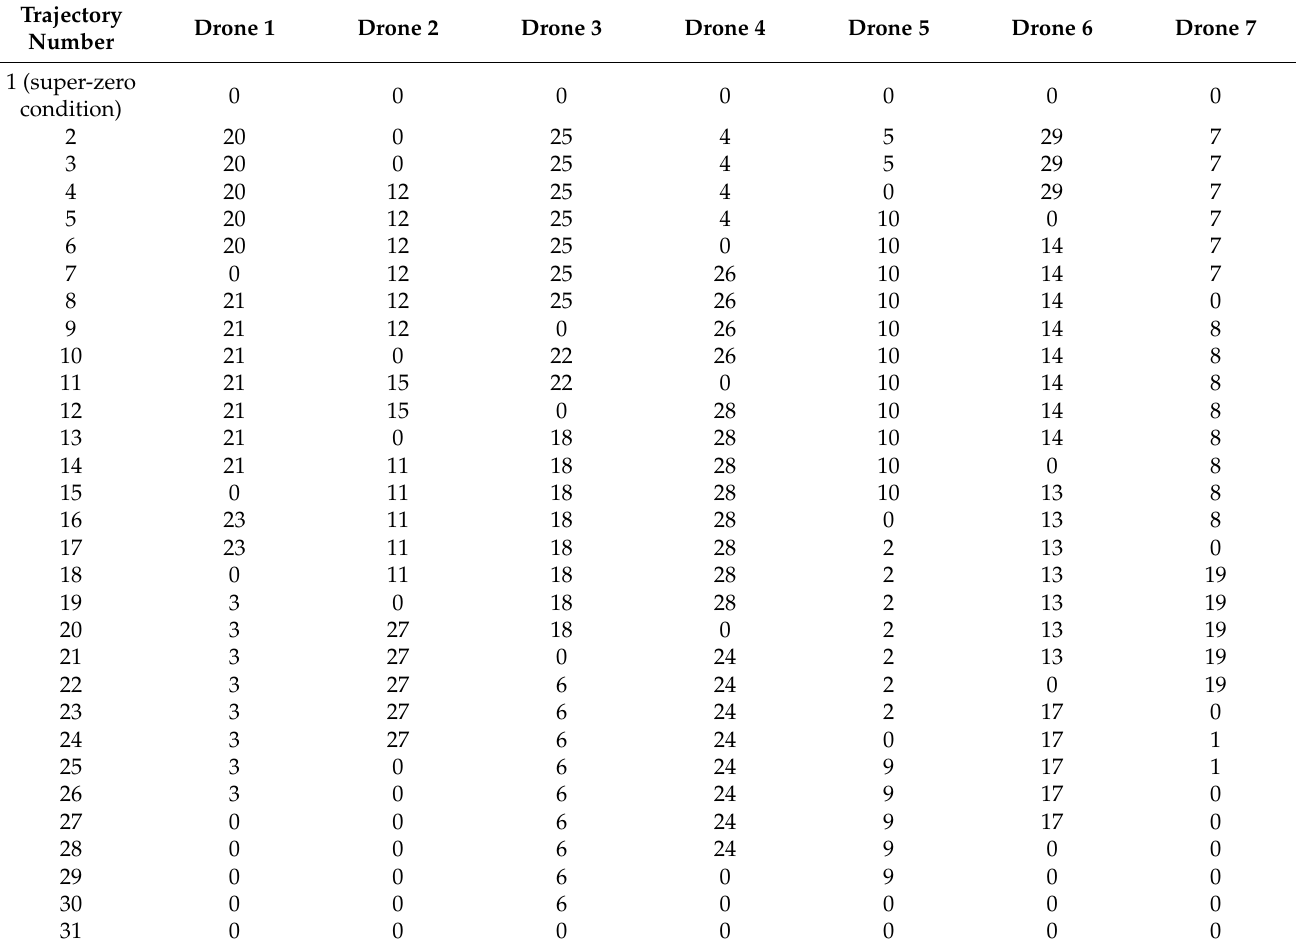
Table 4. Assigned tasks for the UAV